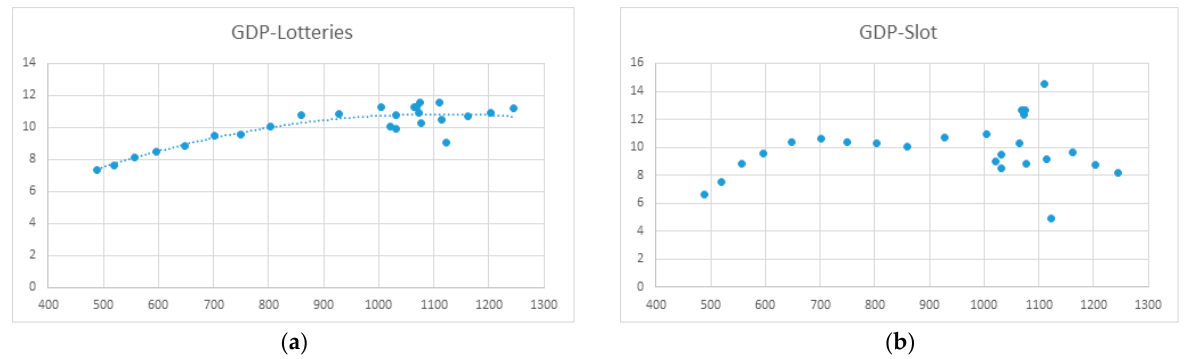
Figure 6. ( a ) Regression function between GDP and lottery spending; ( b ) Regression function between GDP and EGM spending (slot). Regression analyses of GDP and lottery spending established a polynomial regres- sion model: No relationship was identified between GDP and slot machine spending.